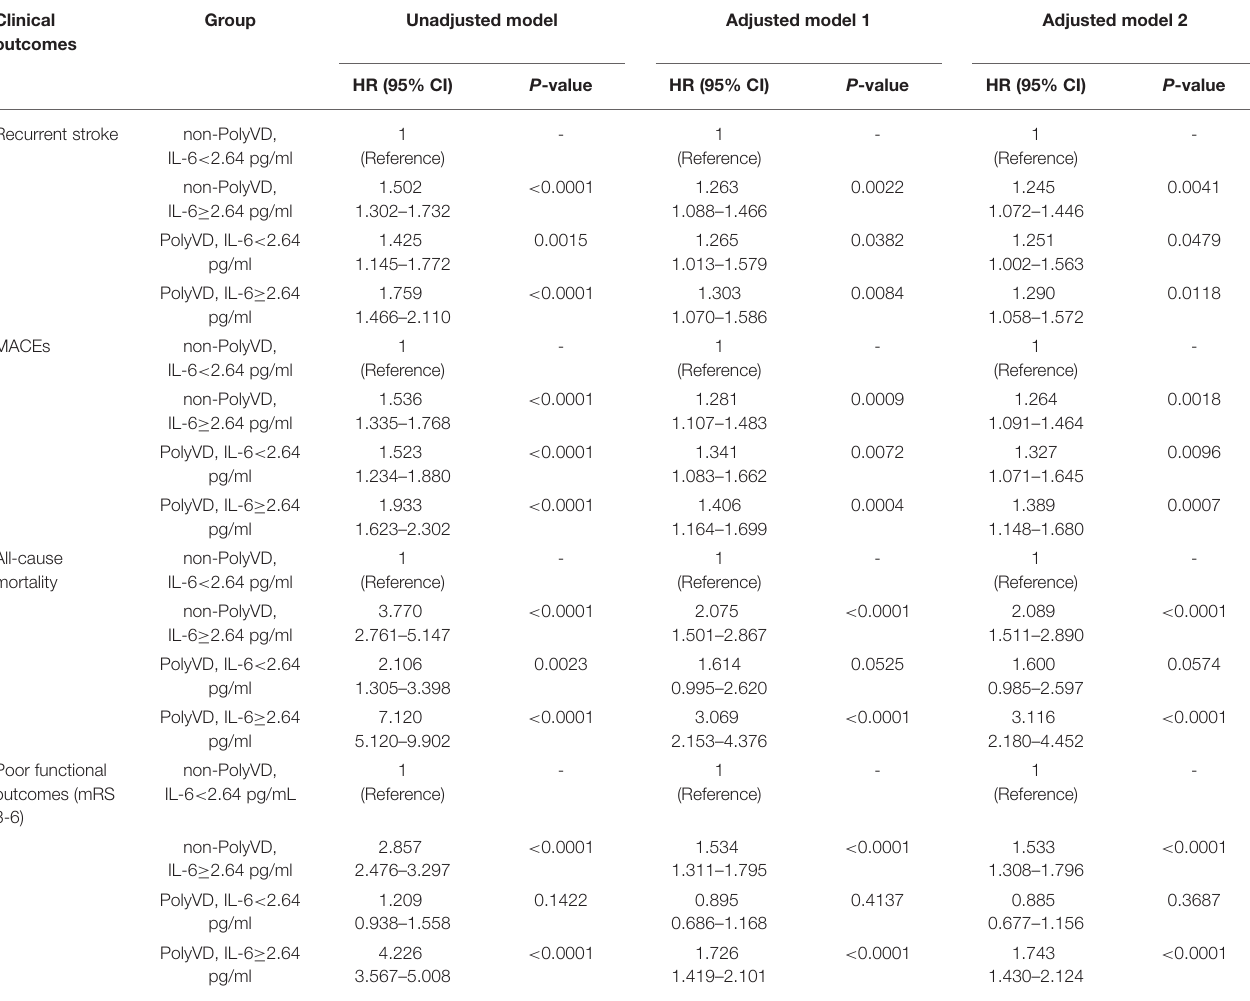
TABLE 3 | HR (95% CIs) of clinical outcomes according to atherosclerosis vascular beds involvement numbers and IL-6 level in patients with AIS or TIA at 1 year